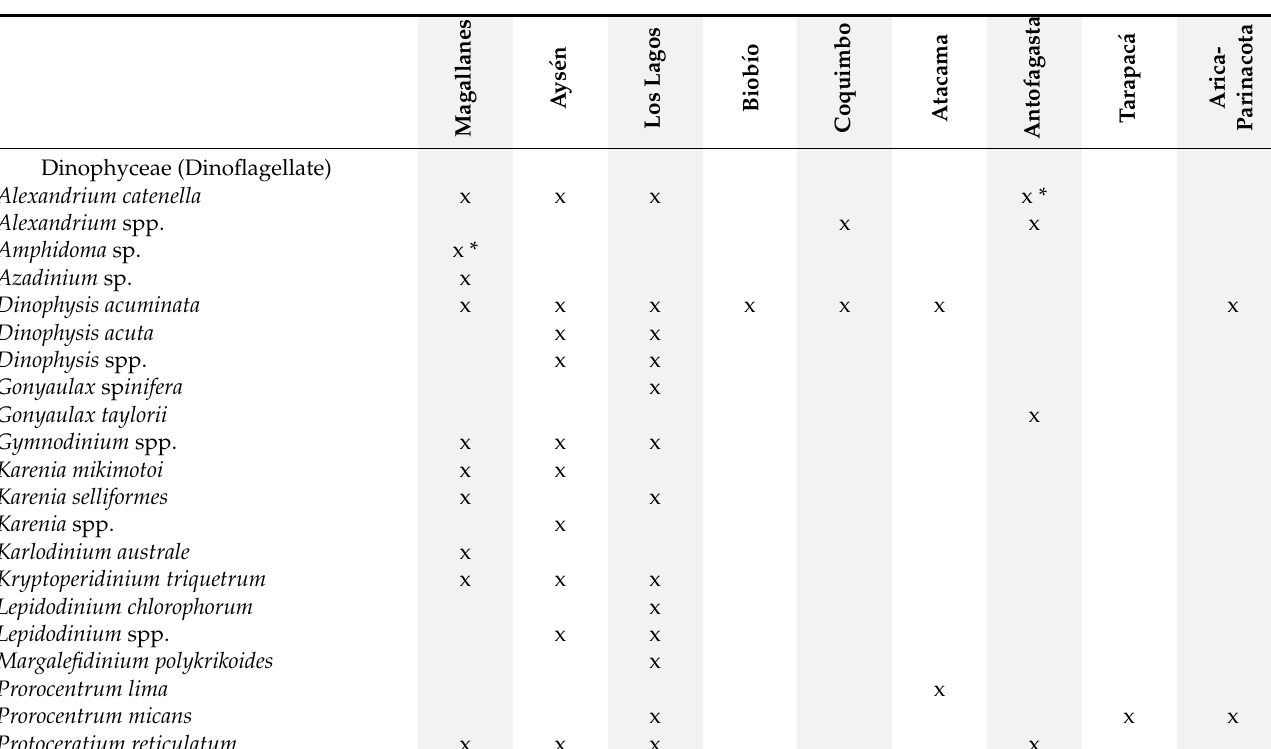
Figure 2. Occurrence of HABs in Chile from 1956 to 2021, ( A ) species that causes HABs by group and ( B ) HABs events per group. Table 3. Species that caused HABs events in the different regions of Chile, from south to